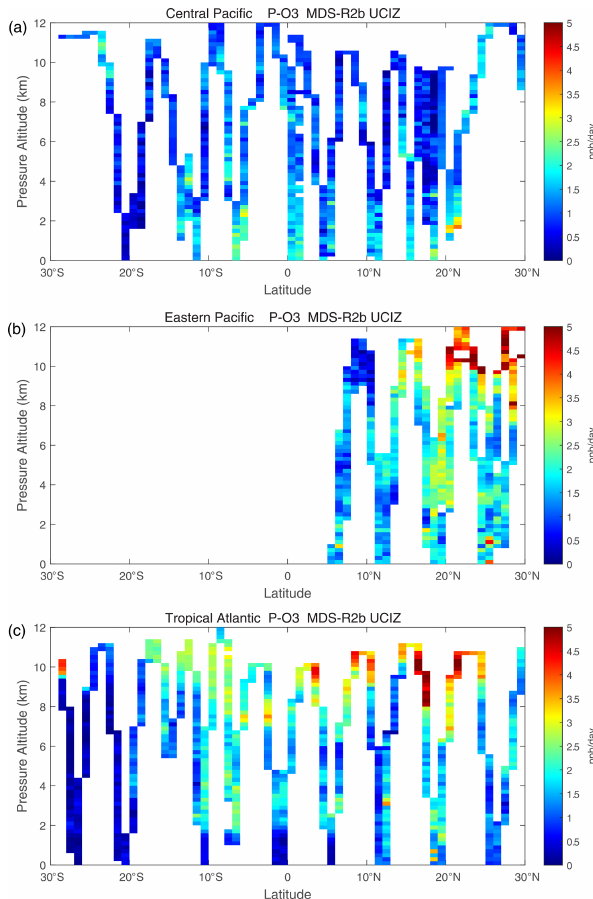
x production and export over the adjacent